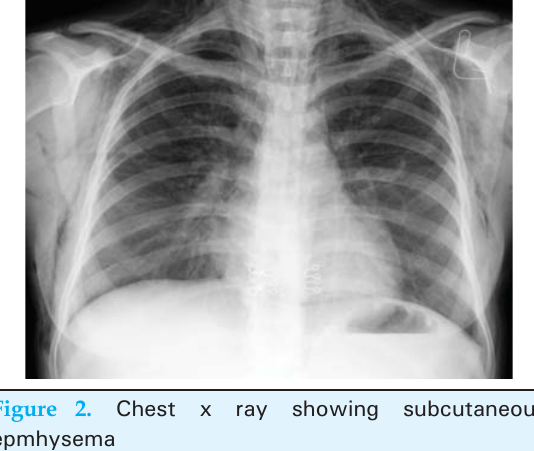
Figure 2. Chest x ray showing subcutaneous